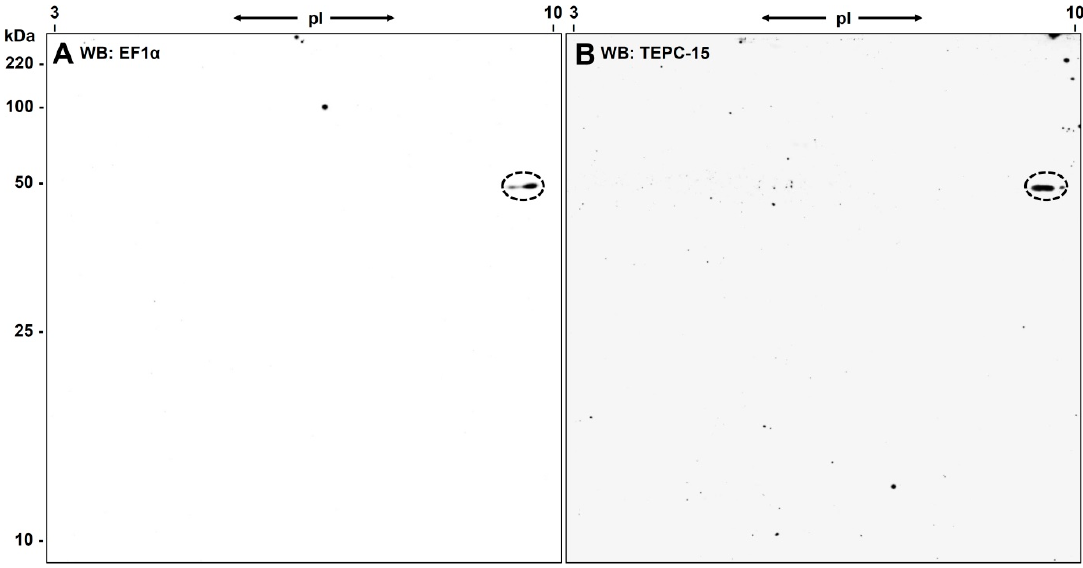
Figure 4. 2D-Western blot analyses with eEF1 α - and PC-specific antibodies. ( A ) ECL of a Western blot probed with PA5-17213, an eEF1 α -specific antibody. The elongation factor is detected at its expected molecular weight (49.5 kDa) but at a slightly higher pI (9.5 compared to an expected pI of 9.03). There is also a second spot of the same size but at lower pI detectable, representing another protein species of eEF1 α ( B ). Both spots of eEF1 α shown in ( A ) are recognized by the PC-specific antibody TEPC-15. Note that this Leishmania were cultivated for ten days but display no difference in PC-substitution compared to the ones cultivated only for three days.